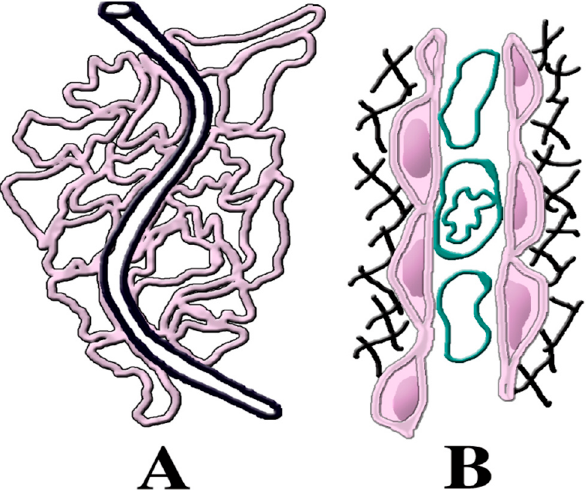
Figure 2. NOVA2 is needed for angiogenesis. ( A ) A low magnification drawing showing angiogenesis in a network of small vessels positive for NOVA2 (rose) growing from a pre-existing vessel (black). ( B ) A growing vessel is shown at higher magnification. The NOVA2-positive flat cells (rose) are endothelia adjacent to the lumen. The latter contains uncolored images of blood cells. The networks on both sides correspond to structures adjacent to the external face of endothelial cells.